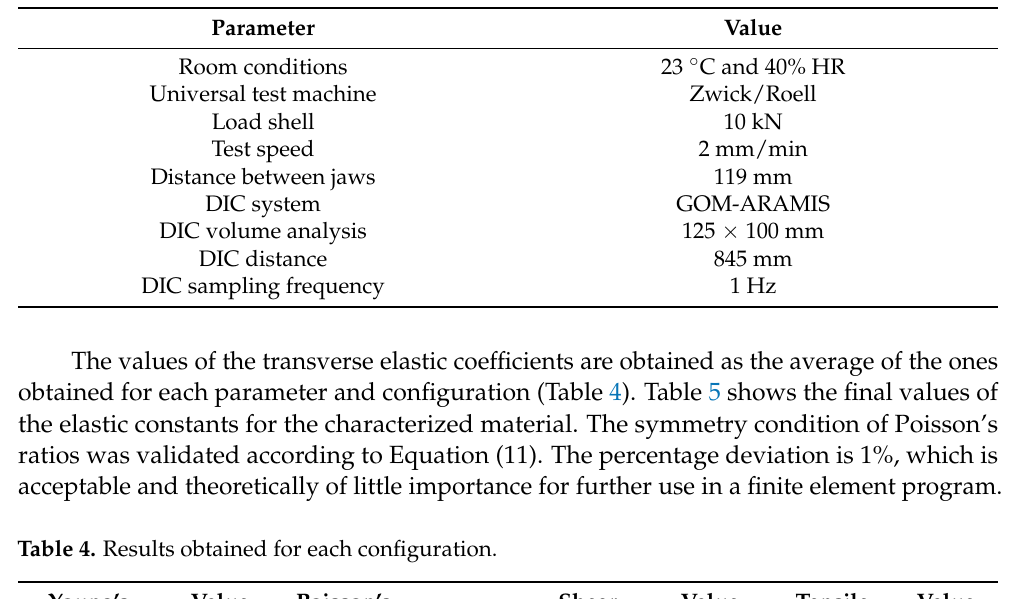
Table 3. Testing conditions.